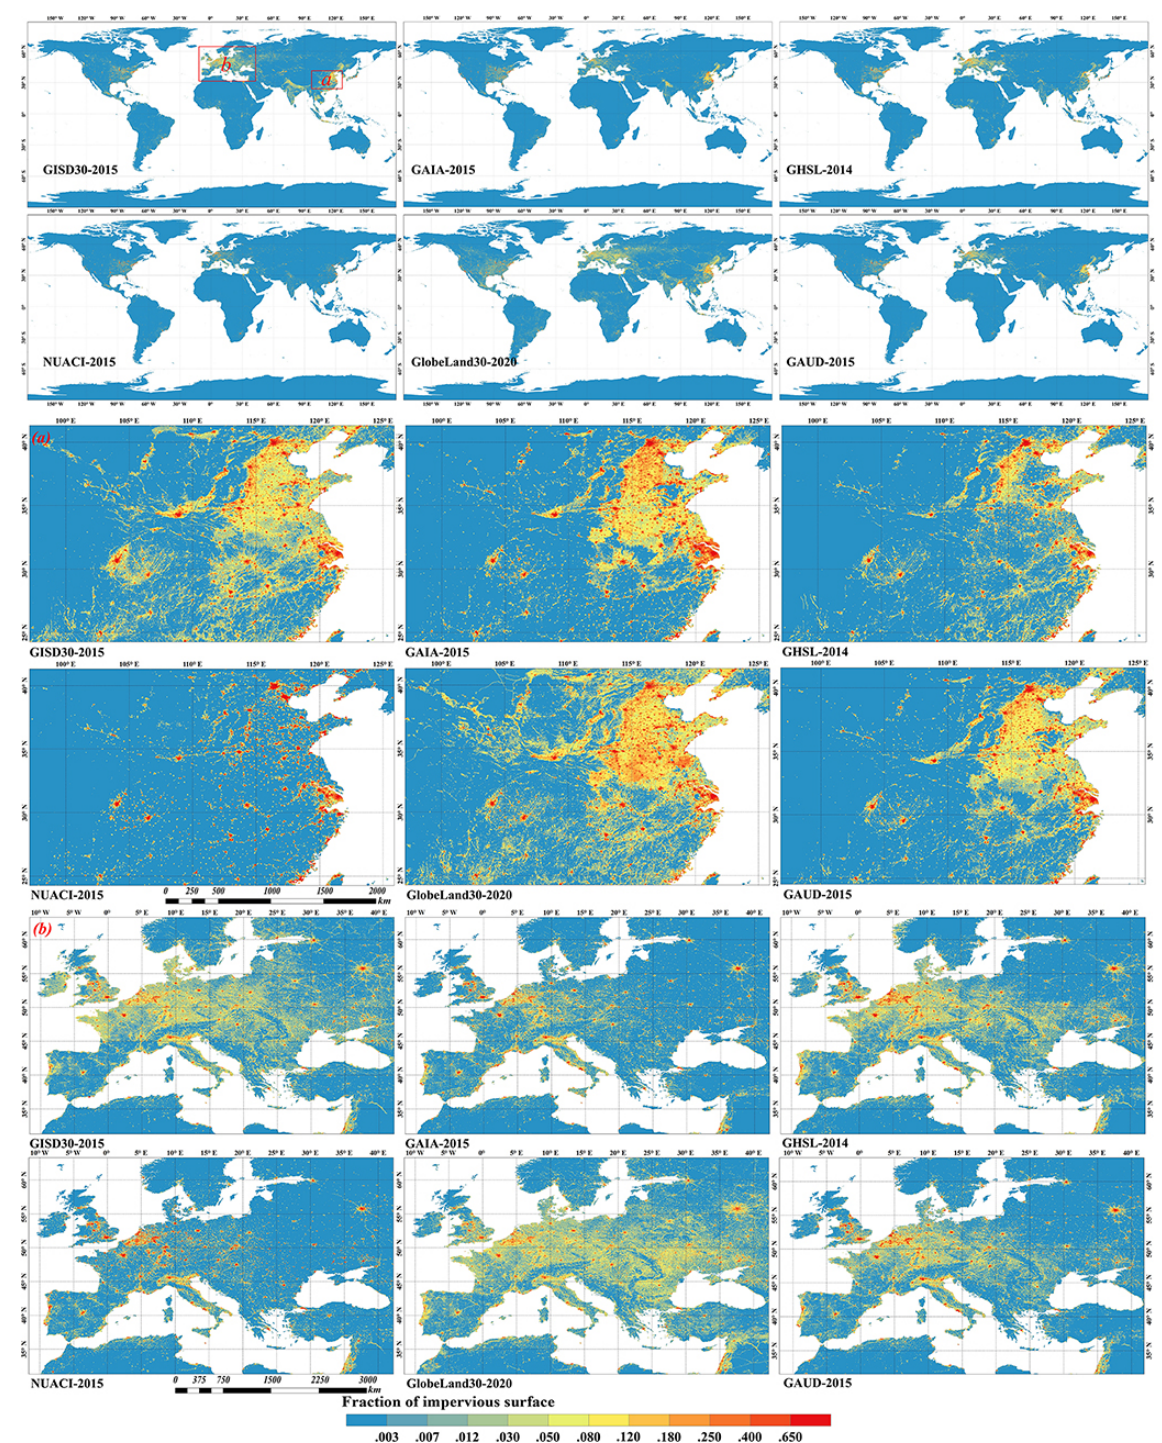
Figure 10. The spatial patterns of six global 30m impervious-surface products and two local enlargements in China (a) and Europe (b) after aggregating to the spatial resolution of 0 . 05 ◦ × 0 . 05 ◦